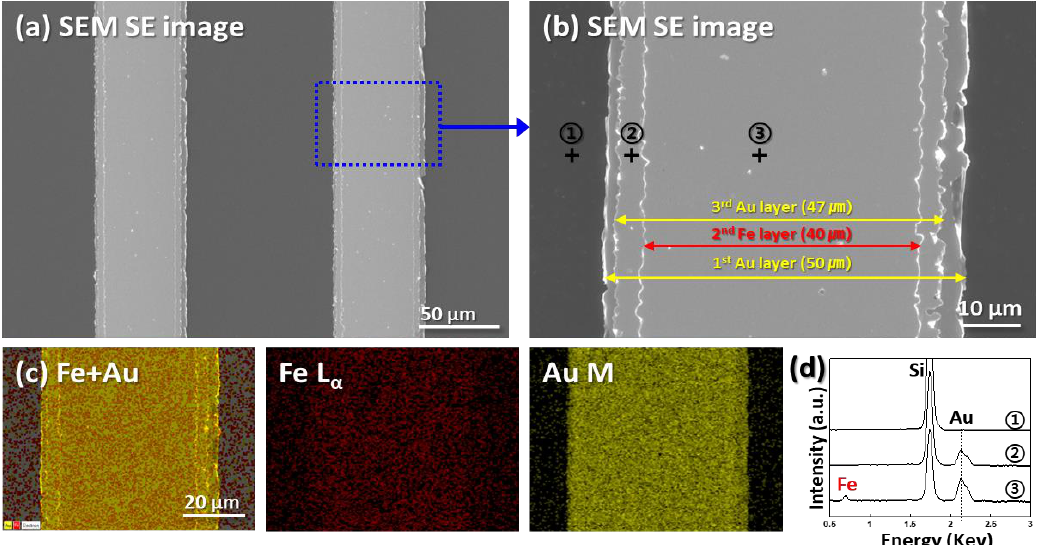
Figure 2. Scanning electron microscopy (SEM) images and energy-dispersive spectroscopy (EDS) images and spectrums of the tri-layer Au/Fe/Au metal catalyst encapsulating Fe after the annealing process.